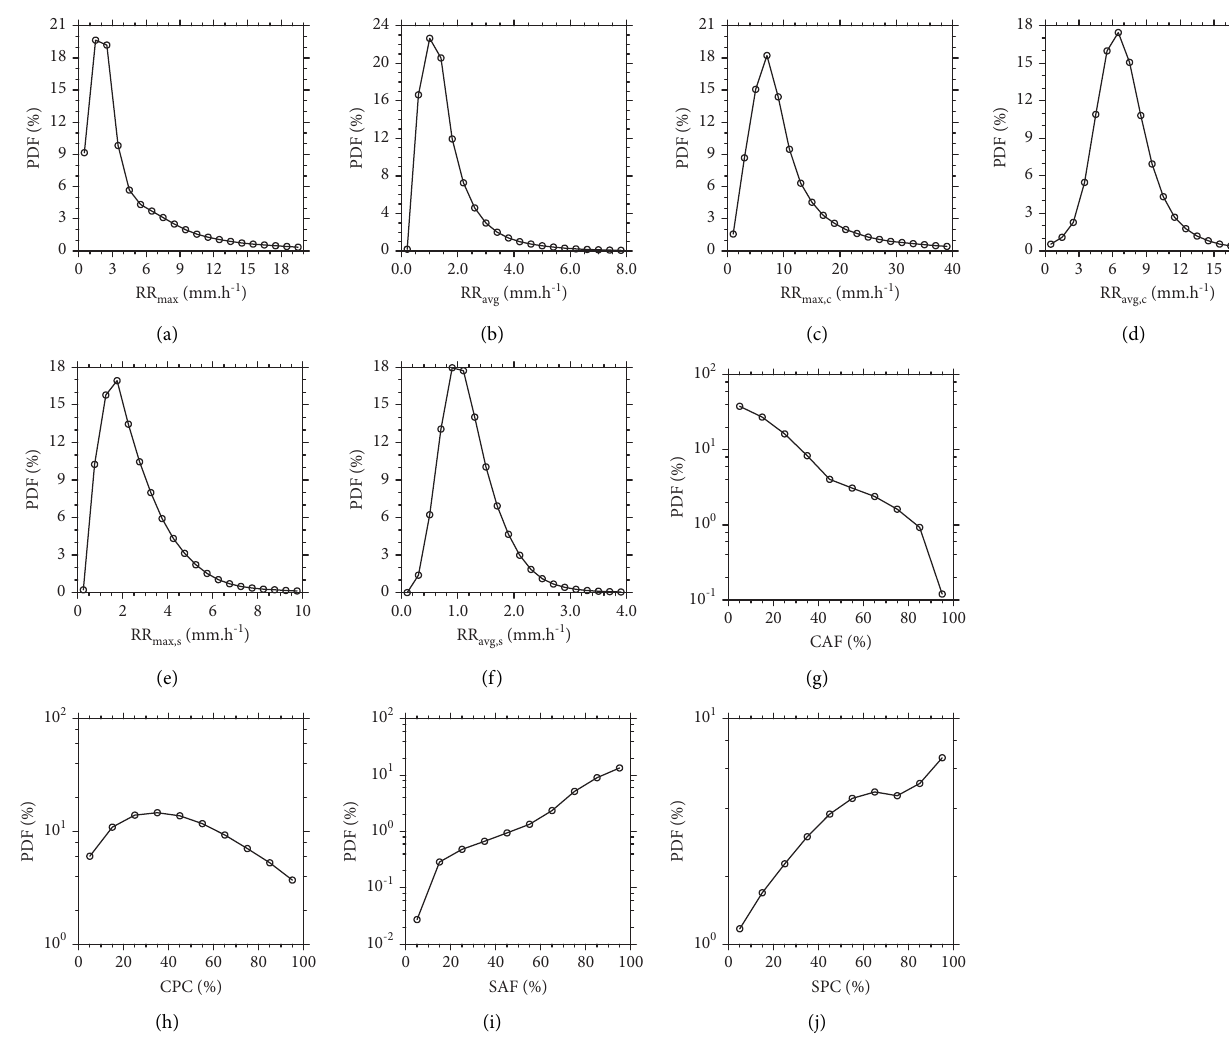
Figure 5: The PDFs of physical parameters for RR max (a), RR avg (b), RR maxc (c), RR avgc (d), RR maxs (e), RR avgs (f), CAF (g), CPC (h), SAF (i), and SPC (j) on Tibetan Plateau from 1998 to